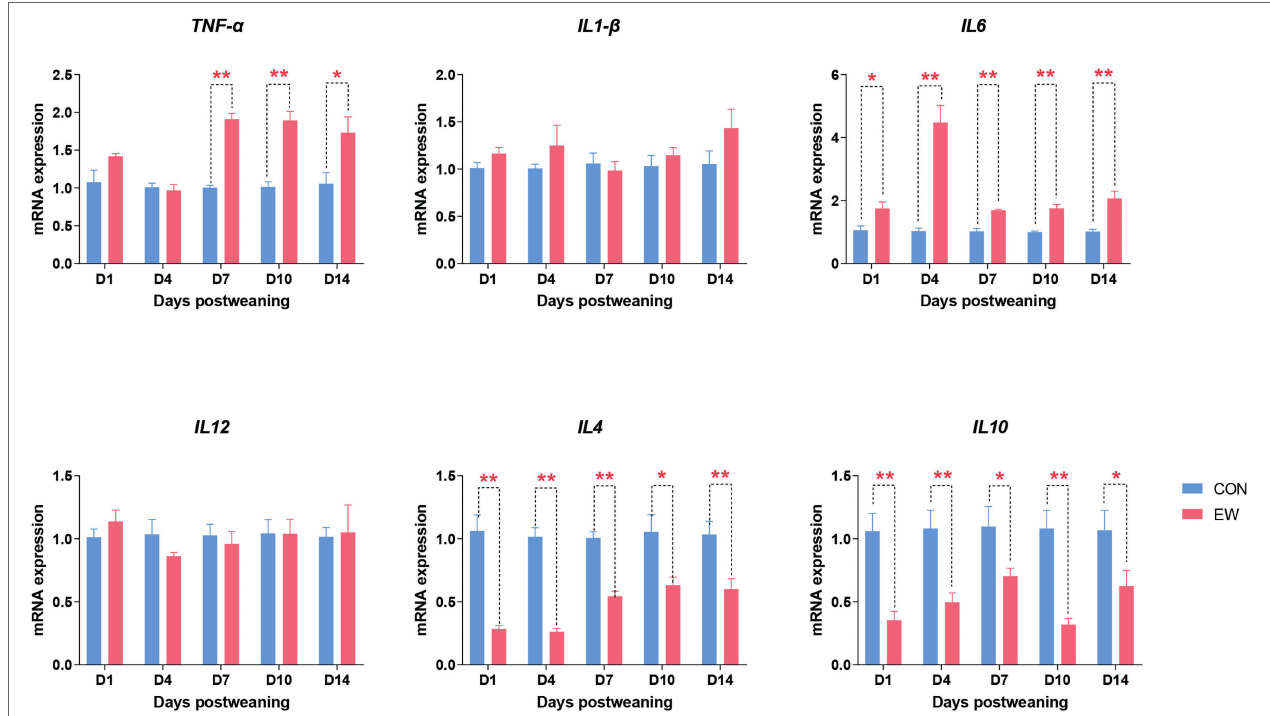
FIGURE 10 | Effects of early weaning on mRNA expression of cytokines in the ileum of squabs. D1, D4, D7, D10, and D14 means 1, 4, 7, 10, and 14 days postweaning, respectively. Values are means with their standard errors of eight squabs. * and ** mean p < 0.05 and p < 0.01, respectively, within each time points postweaning. CON, control group; EW, early weaning group; TNF, tumor necrosis